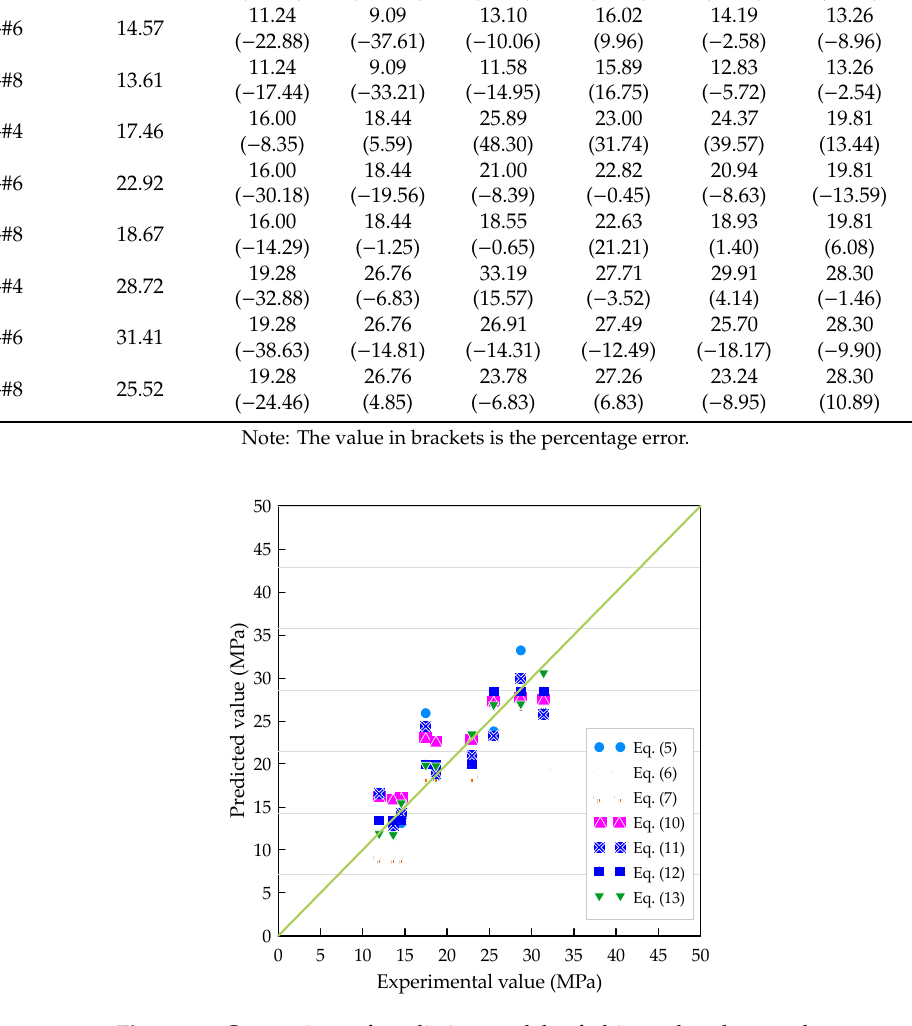
Figure 12. Comparison of prediction models of ultimate bond strength.